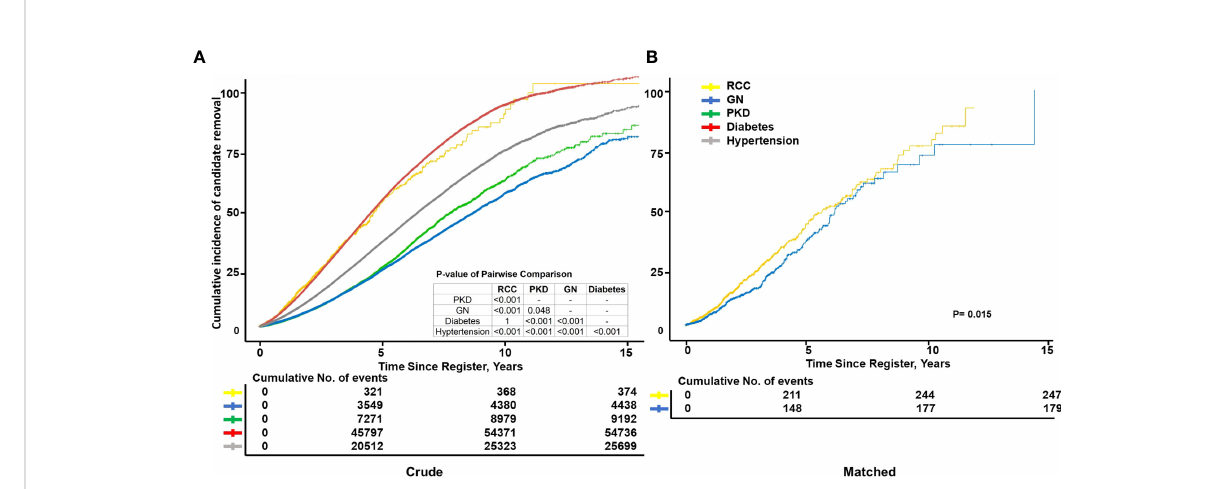
FIGURE 2 Cumulative incidence of candidate removal. Kaplan – Meier curves showing the cumulative incidence of candidate removal due to death and deterioration, including those caused by different primary diseases before transplantation (A) as well as end-stage renal disease (ESRD) caused by renal cell carcinoma (RCC), glomerulonephritis (GN), and primary kidney disease (PKD) after propensity score matching (n=1,312). (B) Exact matching variables: Age, sex, ethnicity, diabetes history, and education level; not exact: Body mass index, primary insurance, and